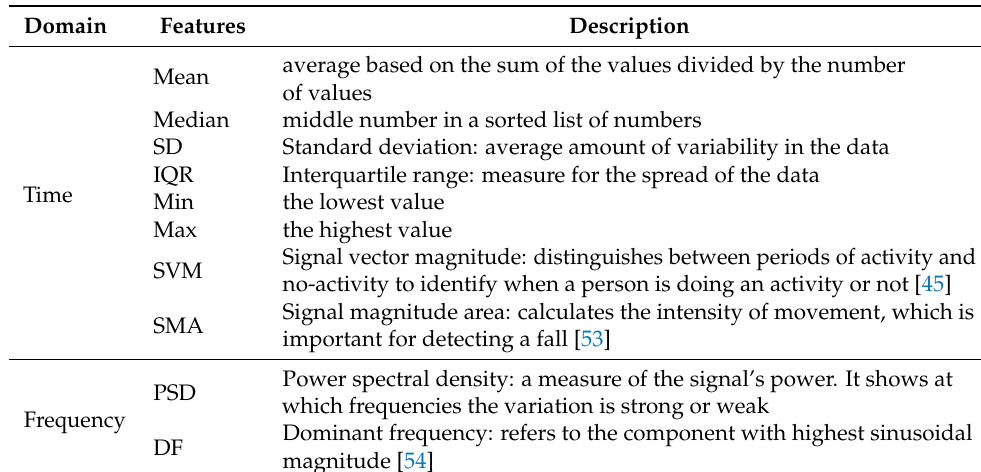
Table 4. Time and frequency domain features used in this study.